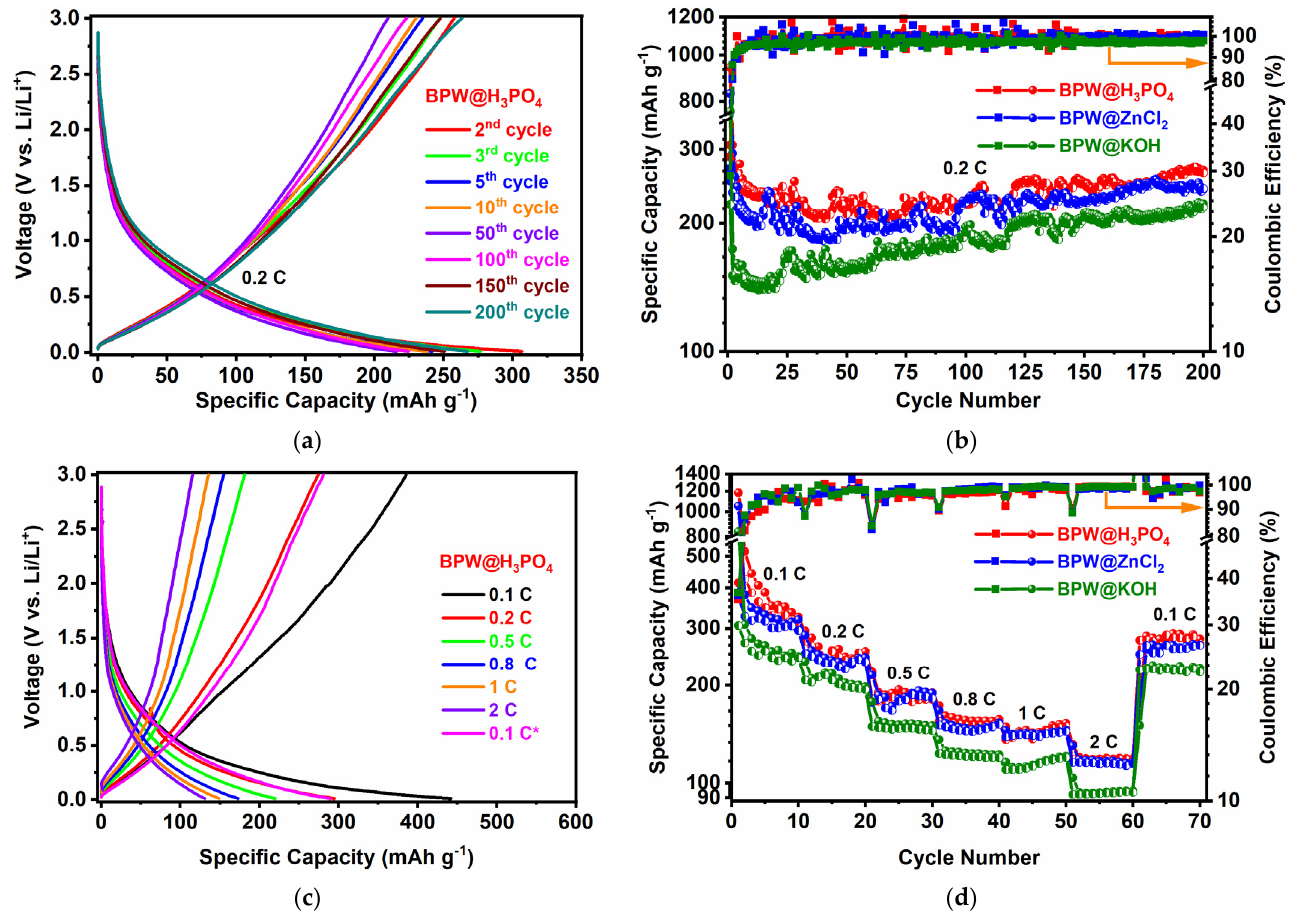
Figure 4. ( a ) Charge–discharge profiles at 0.2 C (74.4 mA g − 1 ) of BPW@H 3 PO 4 anode. ( b ) Specific capacity versus cycle number and coulombic efficiency of activated carbons at 0.2 C. ( c ) Charge–discharge profiles at different current rates of BPW@H 3 PO 4 anode. ( d ) Rate capability tests of activated carbons at different current rates.